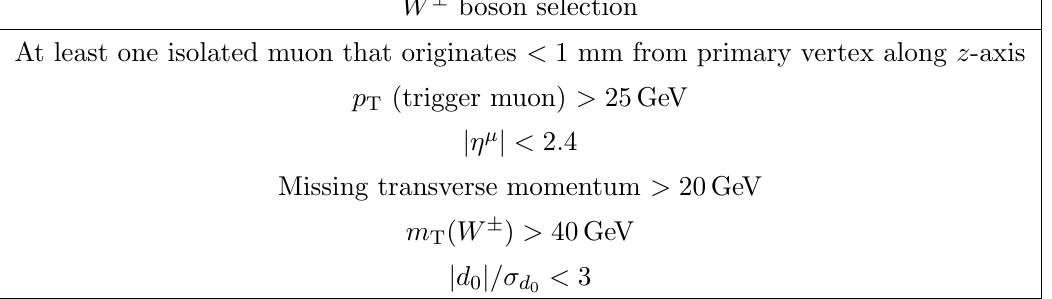
Table 1. Selection criteria for the inclusive W (cid:6) sample, where (cid:22) is the muon from the W (cid:6) boson decay.